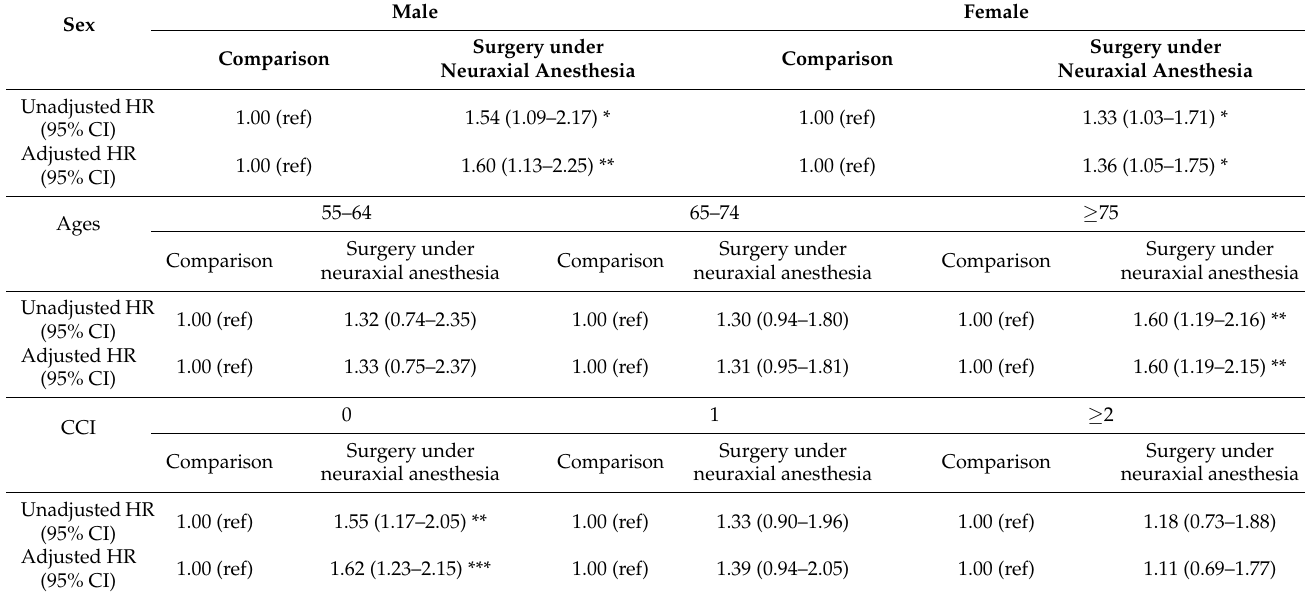
Table 3. Hazard ratios of dementia by sex, age, and comorbidity score between surgery under neuraxial anesthesia and comparison (non-anesthesia).